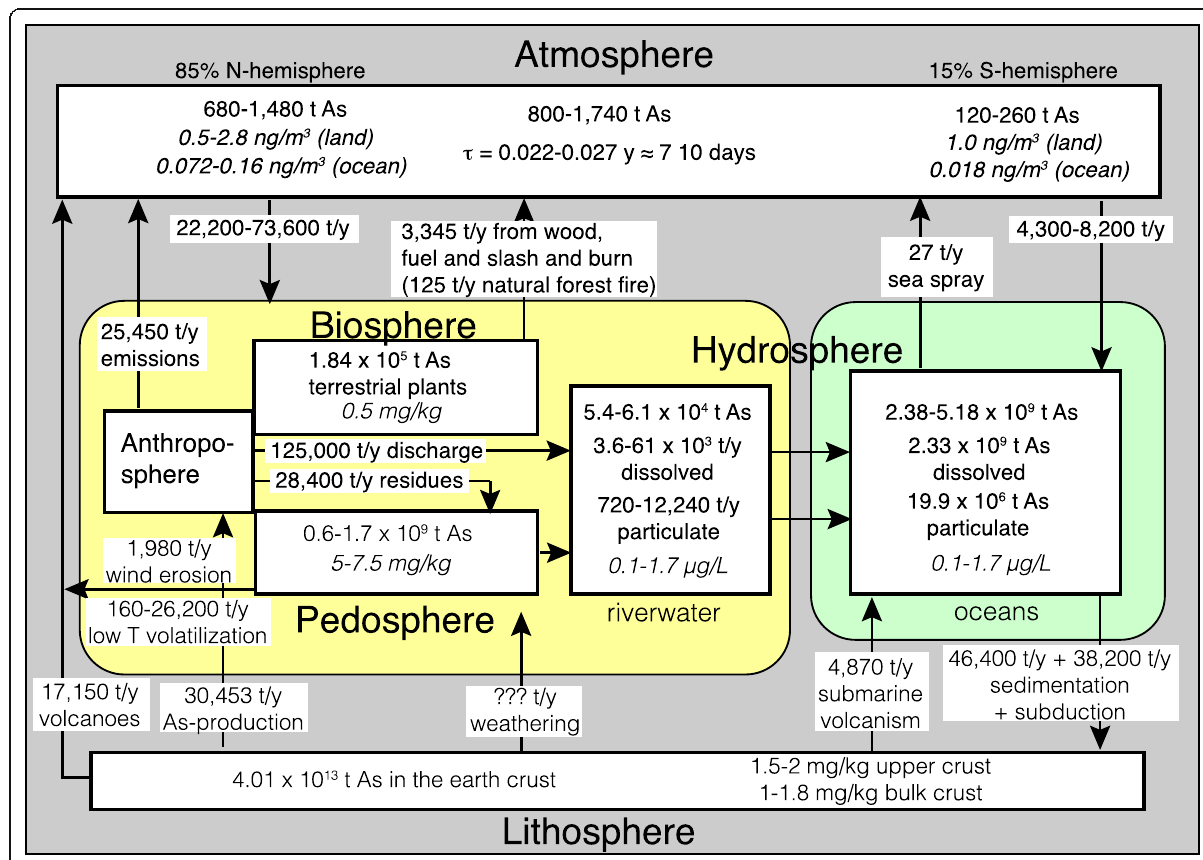
Fig. 1 Global arsenic cycle. Fluxes and reservoir sizes in different parts of the geosphere (Matschullat